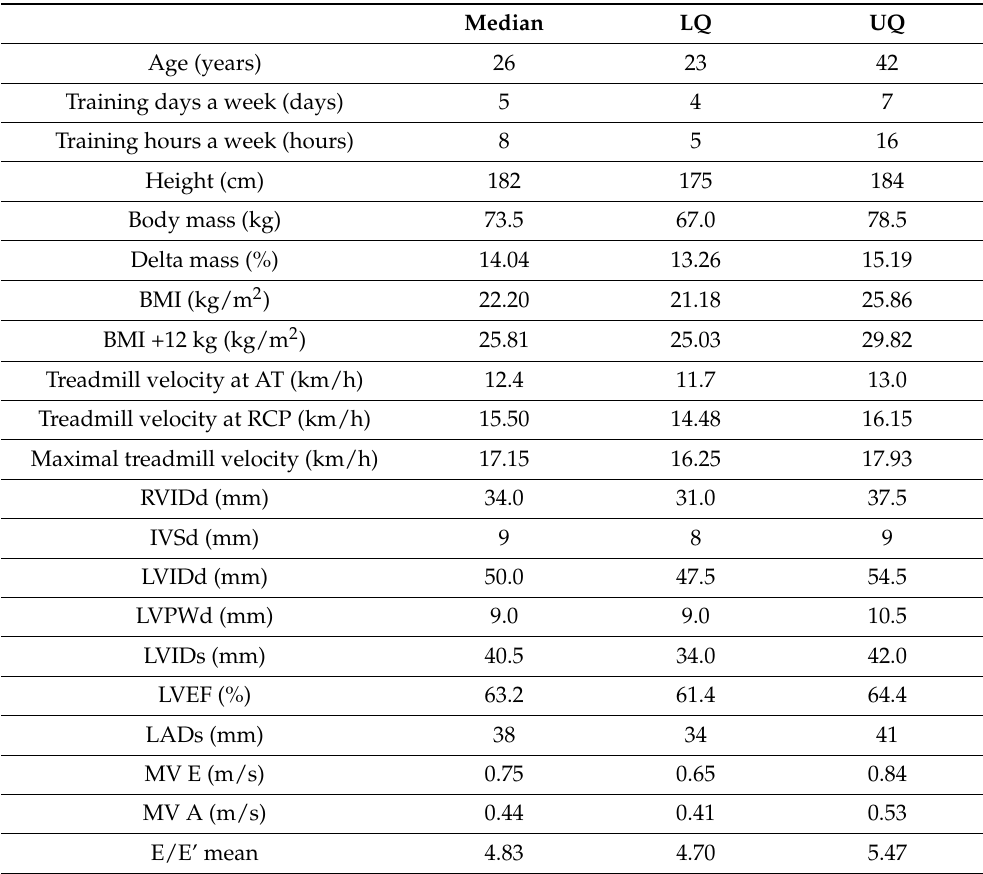
Table 1. Summary baseline characteristics of the healthy male amateur